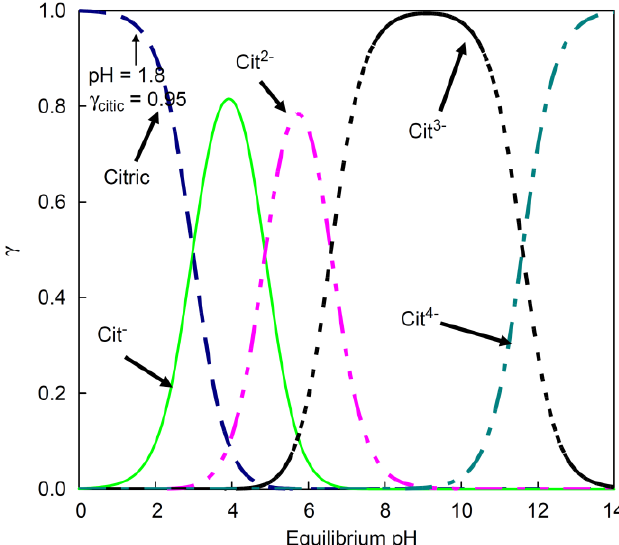
Figure 1. Molar fraction ( γ ) of different citric acid species depending on the equilibrium pH according to Al-Khaldi et al. (2007) at a temperature of 25 °C and a pressure of 1 atm. Reproduced from [10], with copyright permission from Elsevier, 2007.